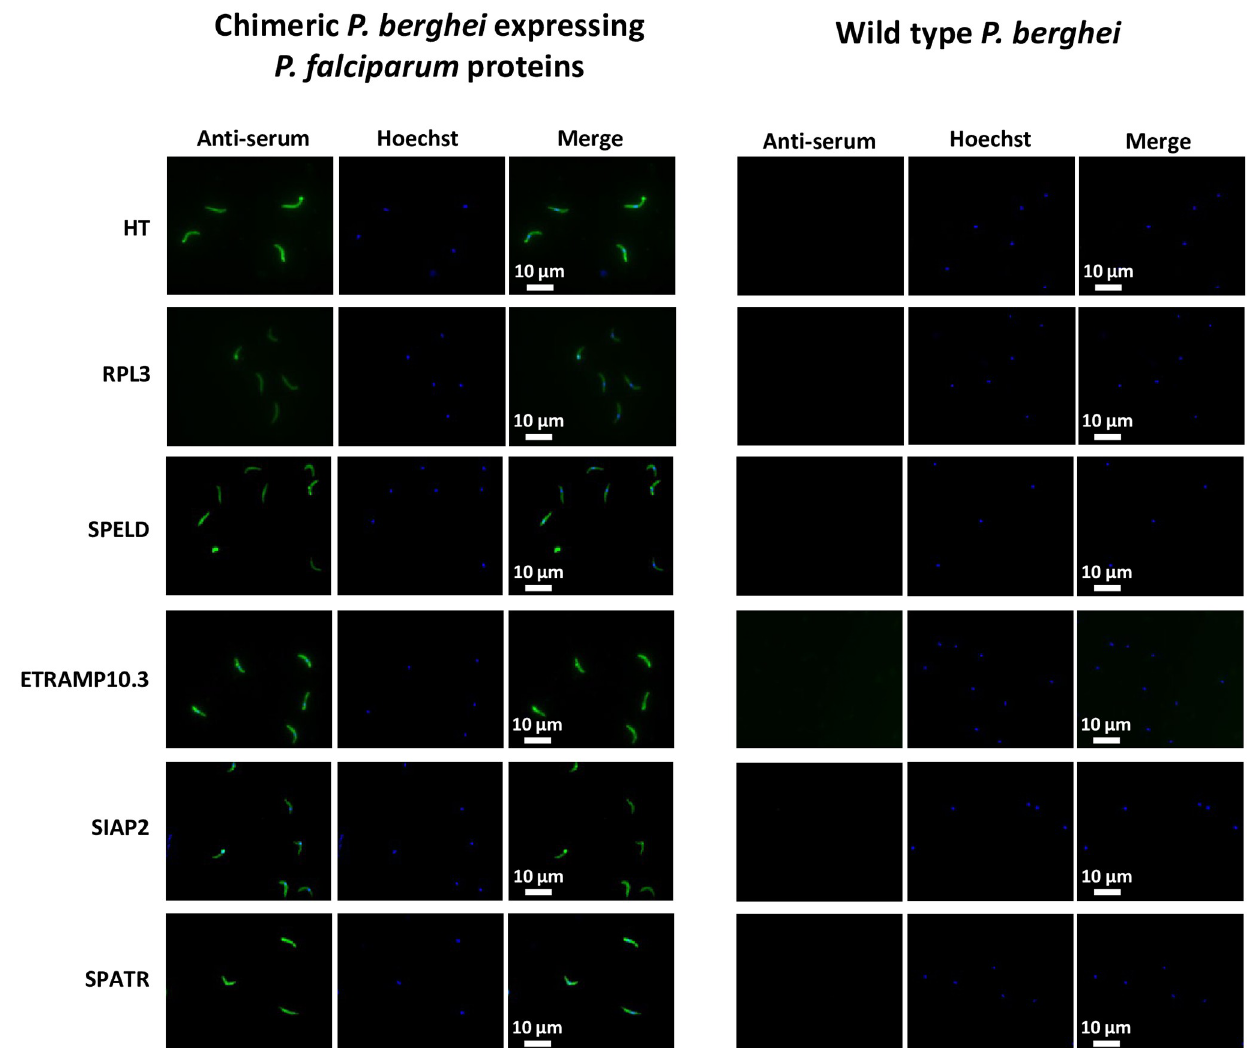
Fig 3. Expression of P . falciparum proteins in chimeric P . berghei sporozoites. Immunofluorescence analysis demonstrating P . falciparum protein expression in chimeric P . berghei sporozoites. Salivary-gland sporozoites of the different chimeric lines were stained with sera from the corresponding vaccinated mice (Alexa Fluor 488, green) and Hoechst-33342 (blue; nuclear staining). As a control, wild-type (WT) P . berghei sporozoites were stained with the same anti-sera. Merged images of the different channels are shown for both chimeric and WT P . berghei sporozoite stained images.